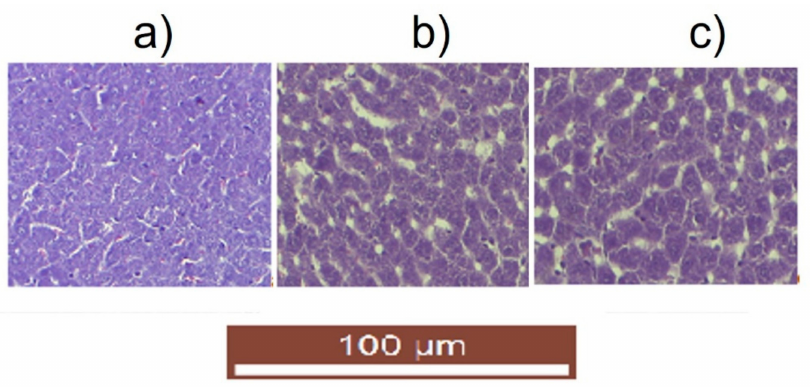
Figure 13. Effects of Amox-loaded hydrogels implantation [( a ) Cp ( b ) AHGel2, ( c ) AHGel4] on liver histology after 7 days of